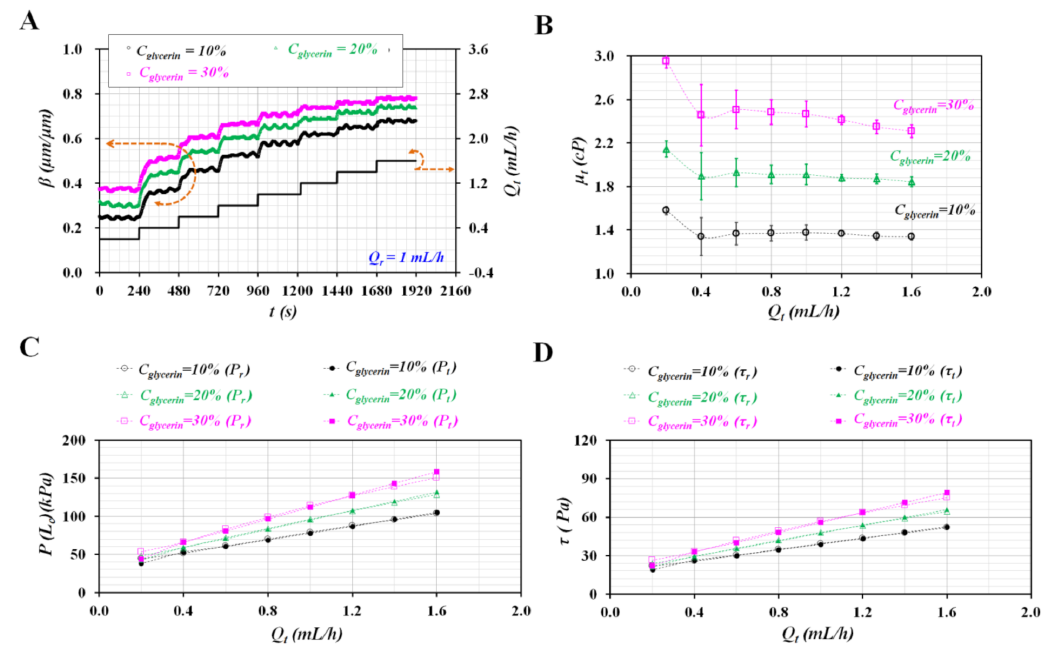
Figure 4. Quantitative comparison of pressure and shear stress for both streams under the stepwise increase in flow rates. 1 × PBS as reference fluid was supplied at the flow rate of 1 mL/h. Flow rate of glycerin solution as test fluid (i.e., C glycerin = 10%, 20%, and 30%) increased stepwise from 0.2 mL/h to 1.6 mL/h. ( A ) Temporal variation of β as well as Q t with respect to C glycerin . ( B ) Variation of viscosity of test fluid with respect to Q t . ( C ) Variation of pressure P r and P t with respect to C glycerin and Q t . ( D ) Variation of τ r and τ t with respect to C glycerin and Q t